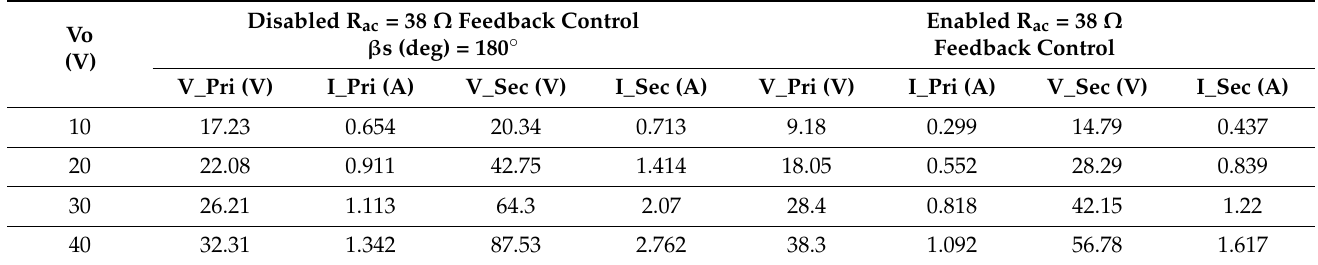
Table 8. Transmitter/receiver RMS voltage/current with R dc = 150 Ω connected.